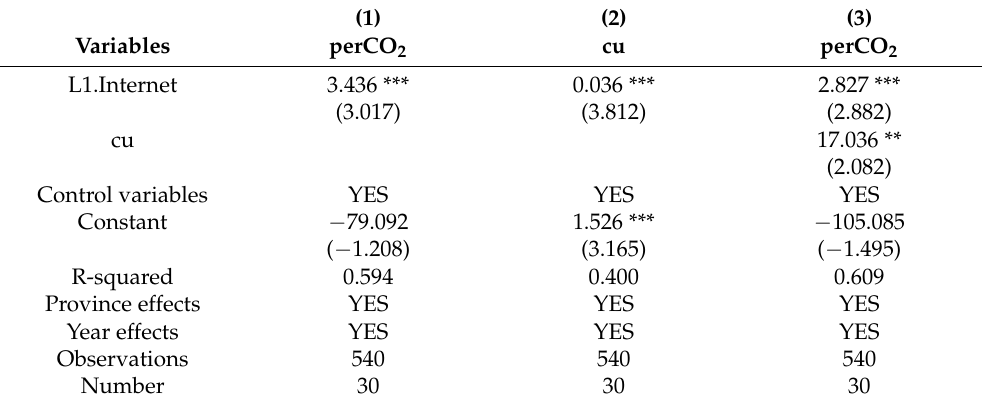
Table 5. Endogenous test